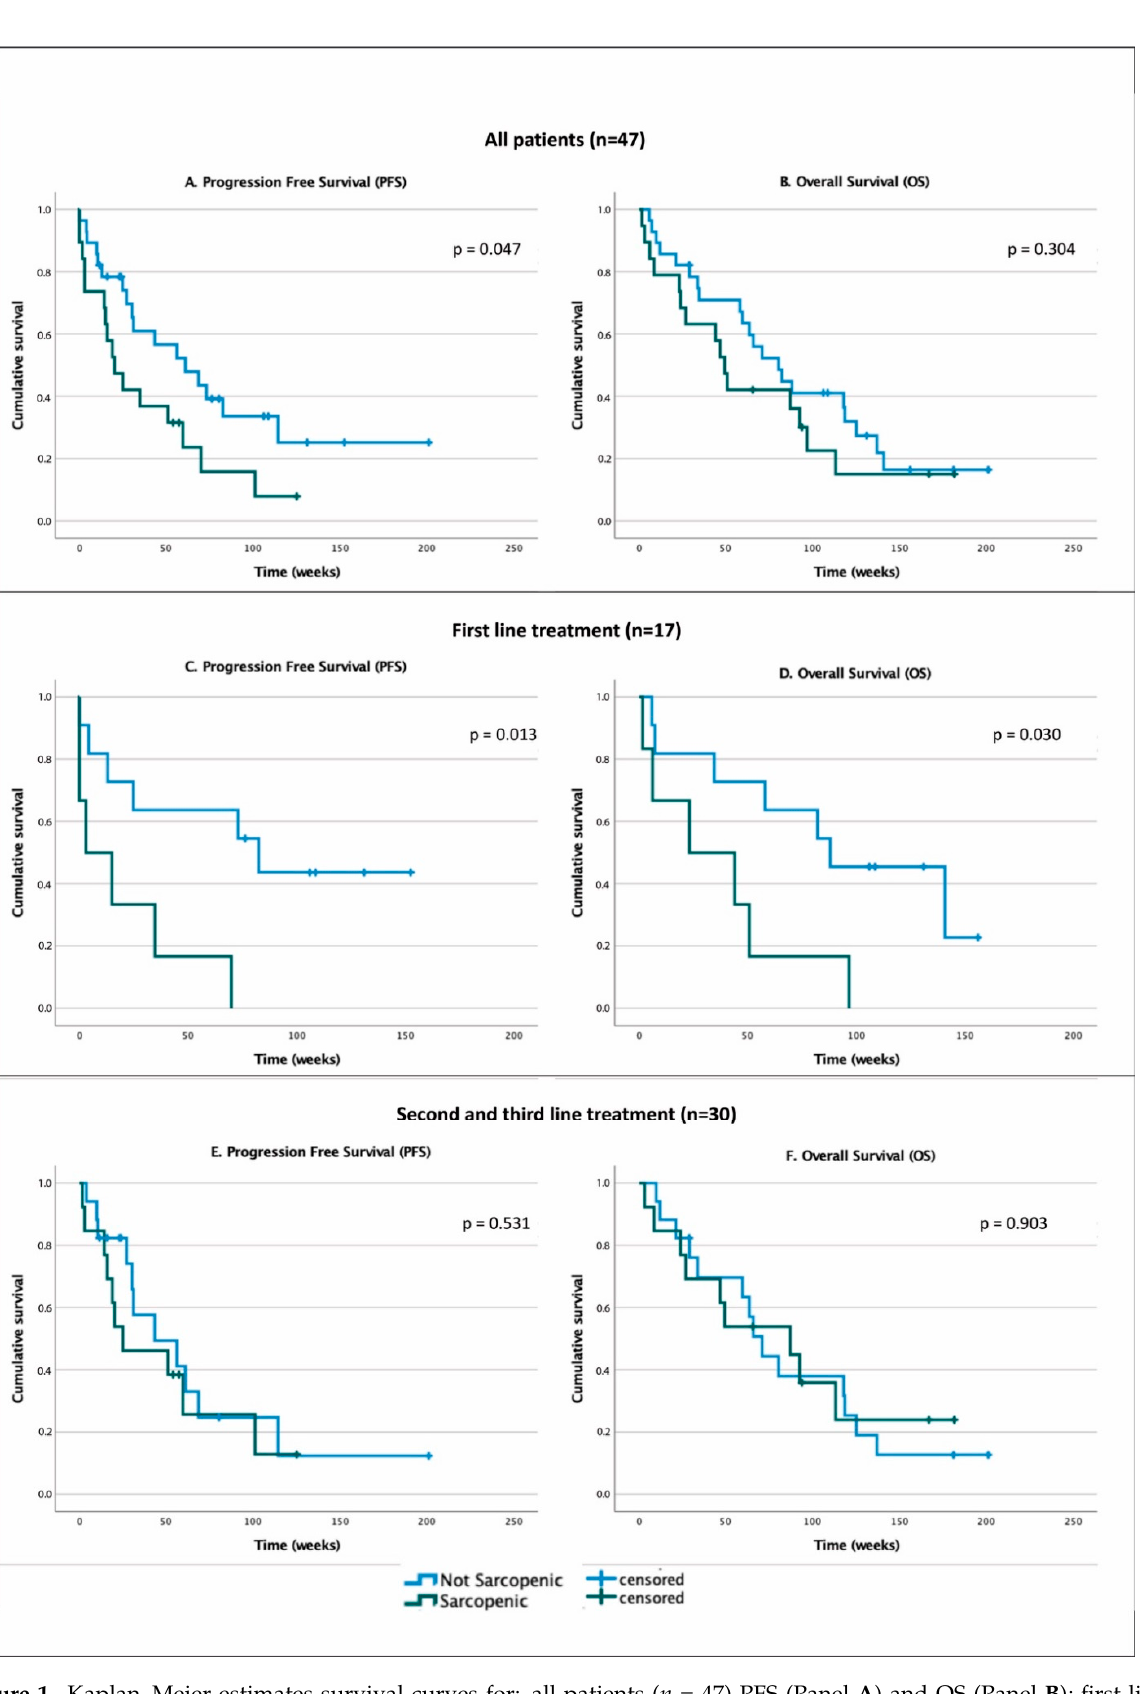
Figure 1. Kaplan–Meier estimates survival curves for: all patients ( n = 47) PFS (Panel A ) and OS (Panel B ); first line treatment ( n = 17) PFS (Panel C ) and OS (Panel D ); second and third line treatment ( n = 30) PFS (Panel E ) and OS (Panel F ).